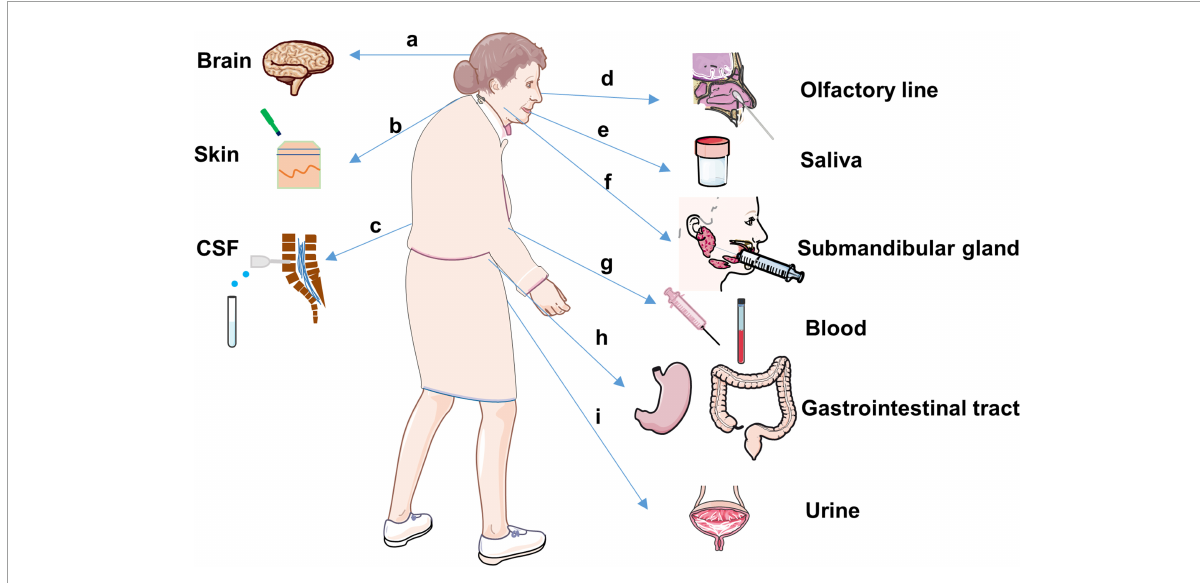
FIGURE3 Tissues and biofluids in α -synucleinopathies for α -Synulein seeding activity